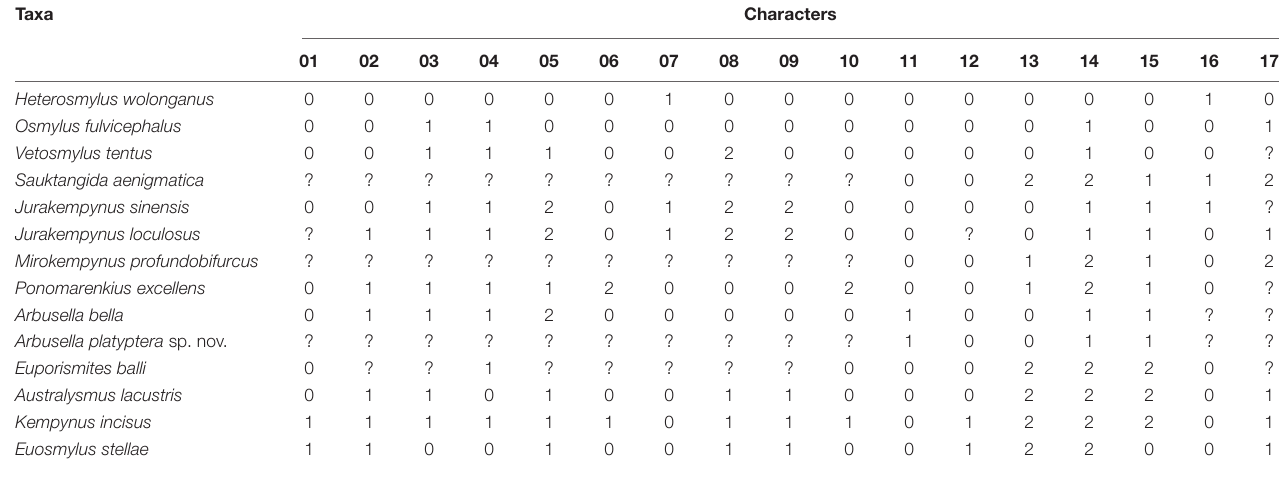
TABLE 2 | Data matrix of characters used in the phylogenetic analyses.